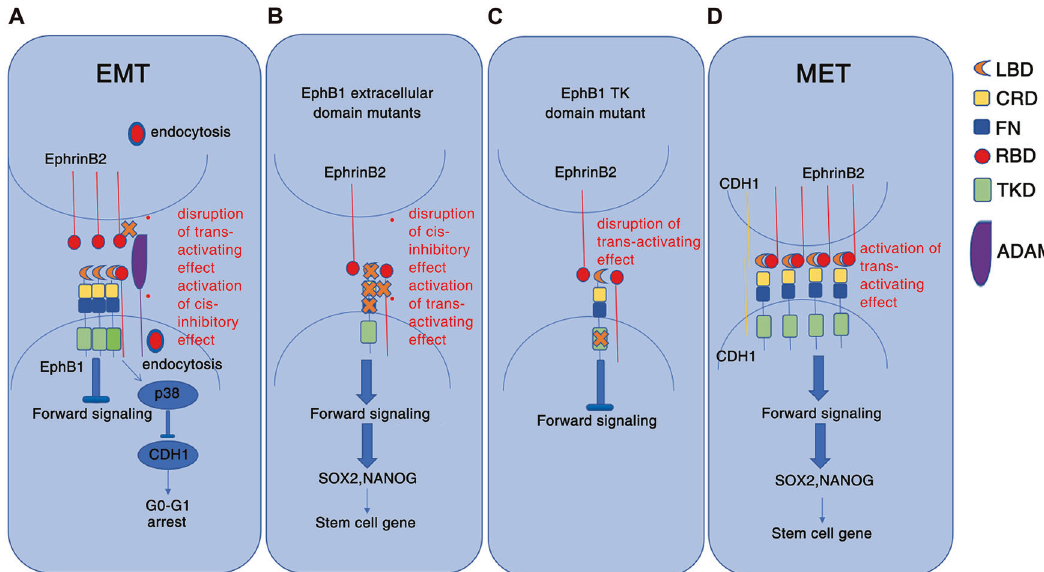
Fig. 9 Schematic mechanism of EphB1 cis and trans signaling controlling the cell dormancy and reactivation after chemotherapy. A In the dormant EMT cells which showed disrupted cell-cell contacts, ligand-independent EphB1 promoted entry of lung cancer cells into G0-G1 phase of cell cycle through activating p-p38 and downregulating E-cadherin; B Interaction of cell-contact-mediated cis- and trans-signalings. Disruption of cis-signaling activates trans-signaling; C Disruption of trans-signaling inhibits EphB1 forward signaling; D In the state of MET, in which cell-cell adhesion was recovered, interactions of EphB1 and ligand EphrinB2 in trans promoted the stemness of cancer cells through upregulating Nanog and Sox2.